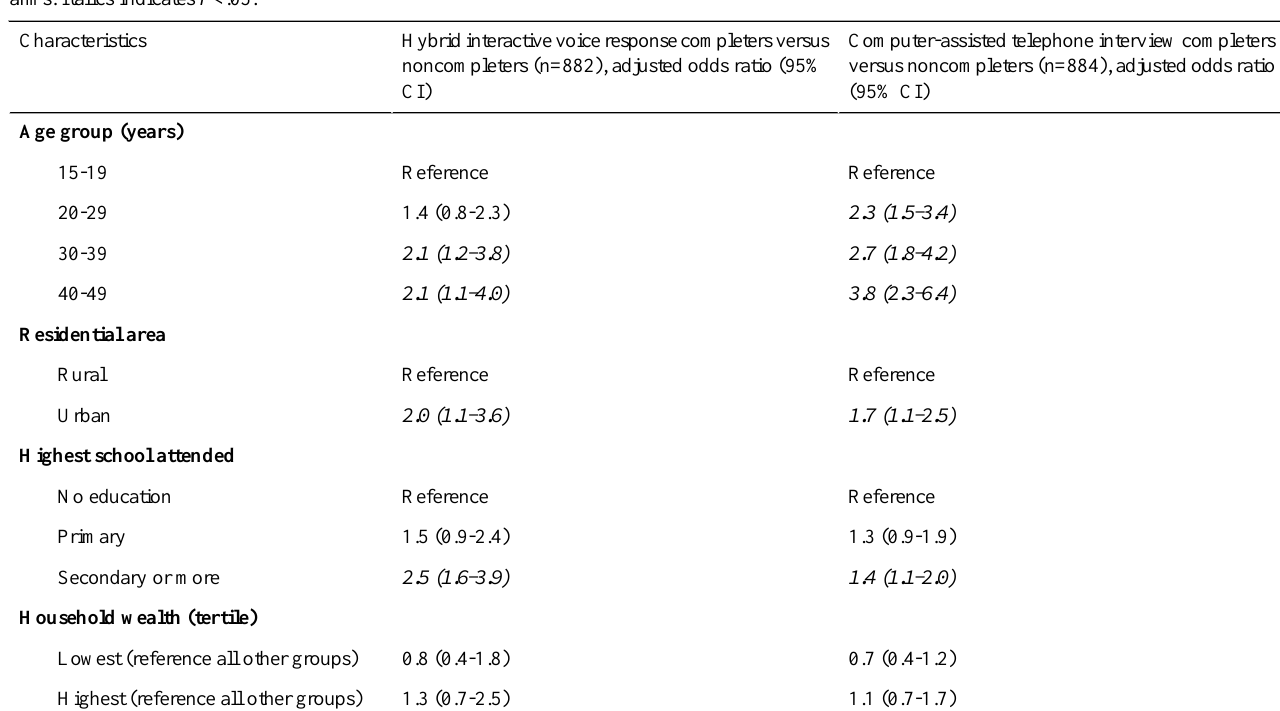
Table 5. Odds of completing the phone follow-up survey by background characteristics: multivariable logistic regression analyses among the 2 study arms. Italics indicates P <.05.